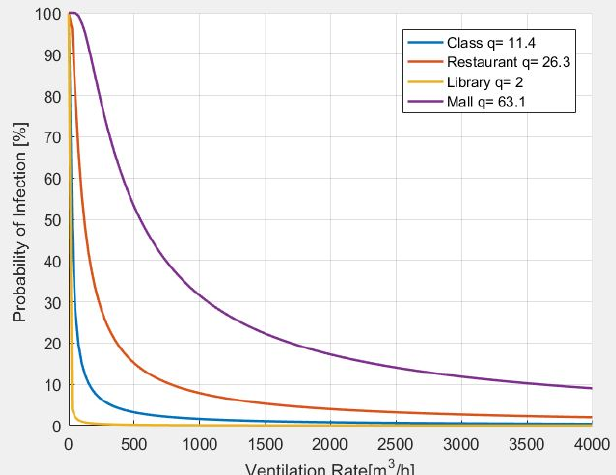
Figure 6. Probability of infection and required ventilation rate for different indoor environments.